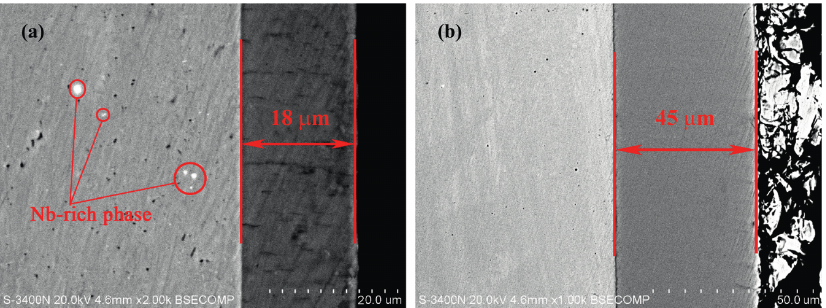
Figure 1: Cross-sectional BSE micrographs of original Cr electroplating on Super304H (a) and TP304H